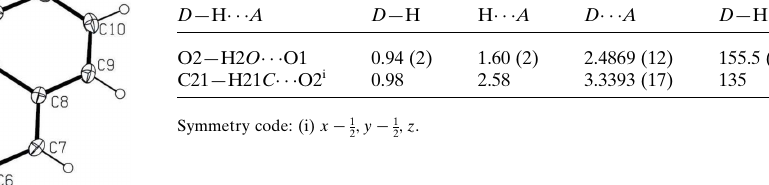
Table 2 Experimental details.